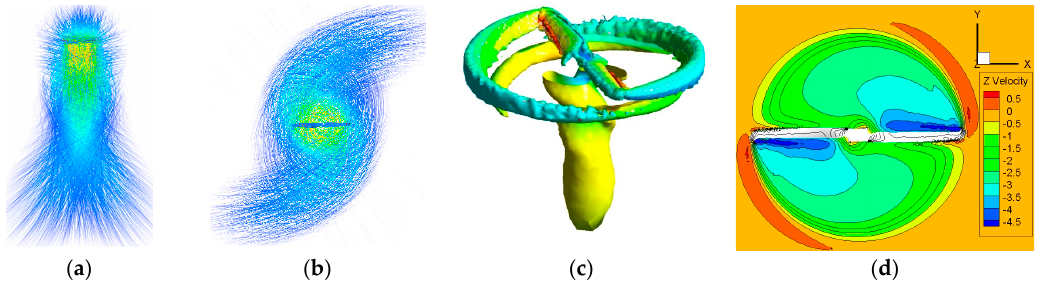
Figure 7. Simulation results of the isolated rotor: ( a ) Radial flow of an isolated rotor; ( b ) axial flow of an isolated rotor; ( c ) vortices distribution defined by the Q criterion at 55,840 s − 2 and 816 s − 2 ; ( d ) vertical velocity contour of the isolated rotor.